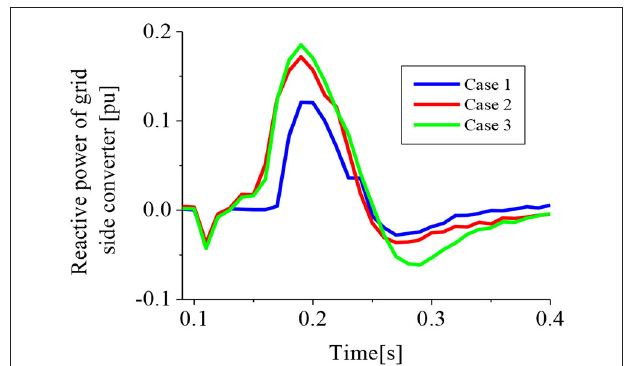
FIGURE 9 | Reactive power of GSC of DFIG (cases